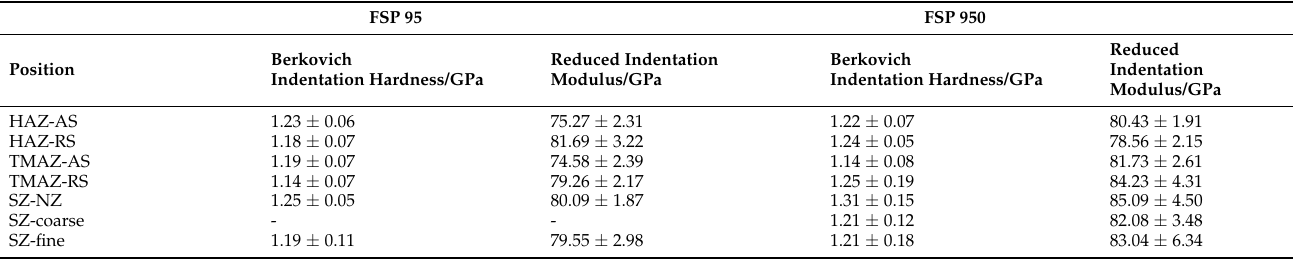
Table 3. Berkovich indentation hardness at specific positions. The average values and standard deviations for 25 measurements, the maximum load was 10 mN. FSP 95 FSP 950 Position Berkovich Indentation Hardness/GPa Reduced Indentation Modulus/GPa Berkovich Indentation Hardness/GPa